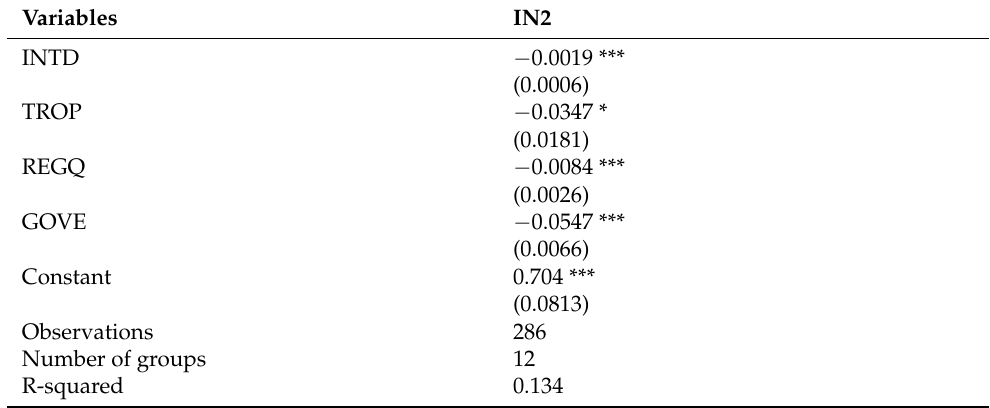
Table 17. Model 7. DV: Income Share of the Top 10% (IN2).